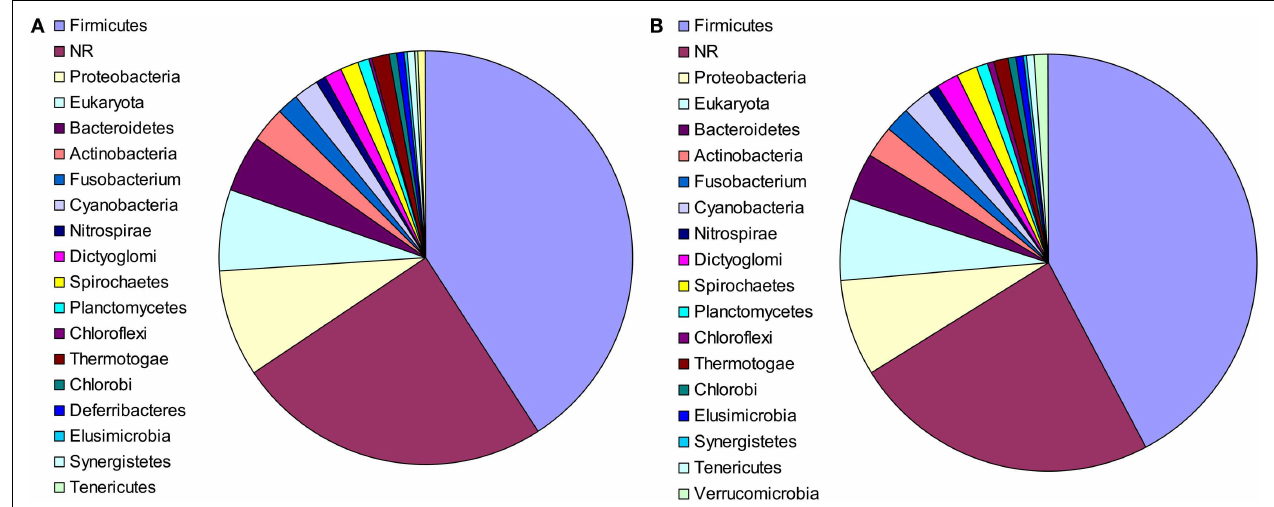
FIGURE 2 |The phylogenetic composition of the closest neighbors of LGT candidates in M. statmanae , based on the reconstructed trees according to (A) Neighbor-joining analysis and (B) RaxML.